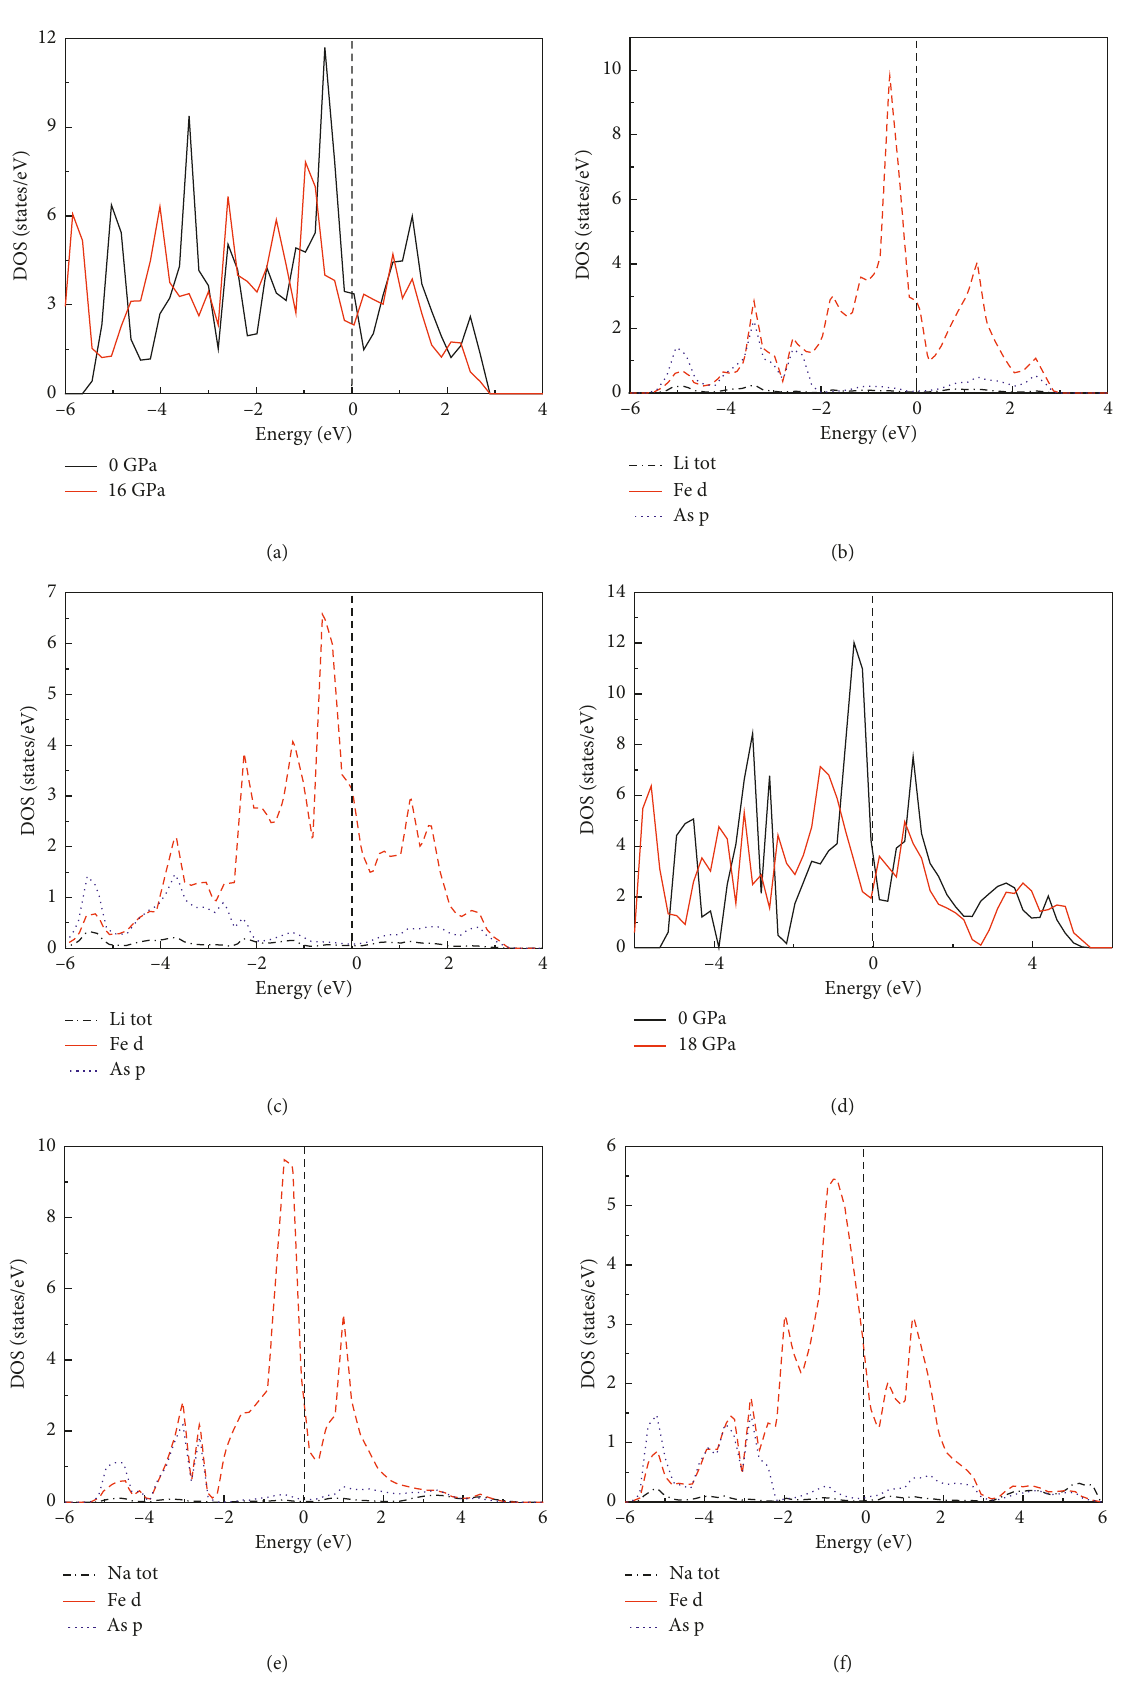
Figure 6: Density of states (DOSs) for LiFeAs (a) at 0 GPa (b) and 16 GPa (c) and NaFeAs (d) at 0GPa (e) and 18GPa (f). Both the total and atomic DOSs are